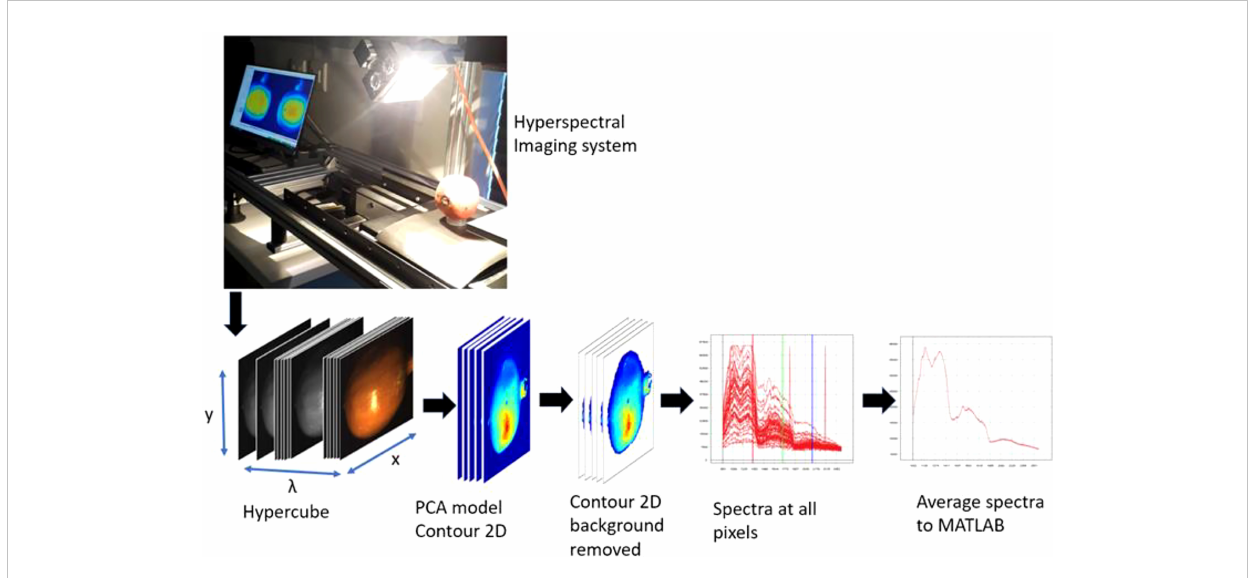
FIGURE 2 Schematics illustrating the hyperspectral imaging and analysis work fl ow followed in this